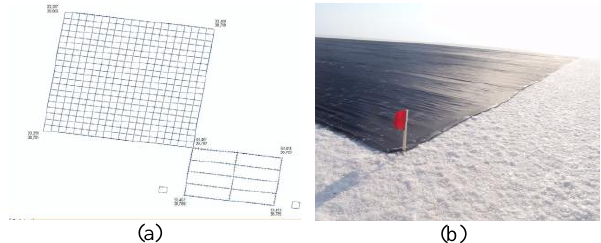
Figure 6. (a) Location of measurement areas and tarpaulins for the 2010 field campaign. (b) Close-up of black fabric tarpaulin.